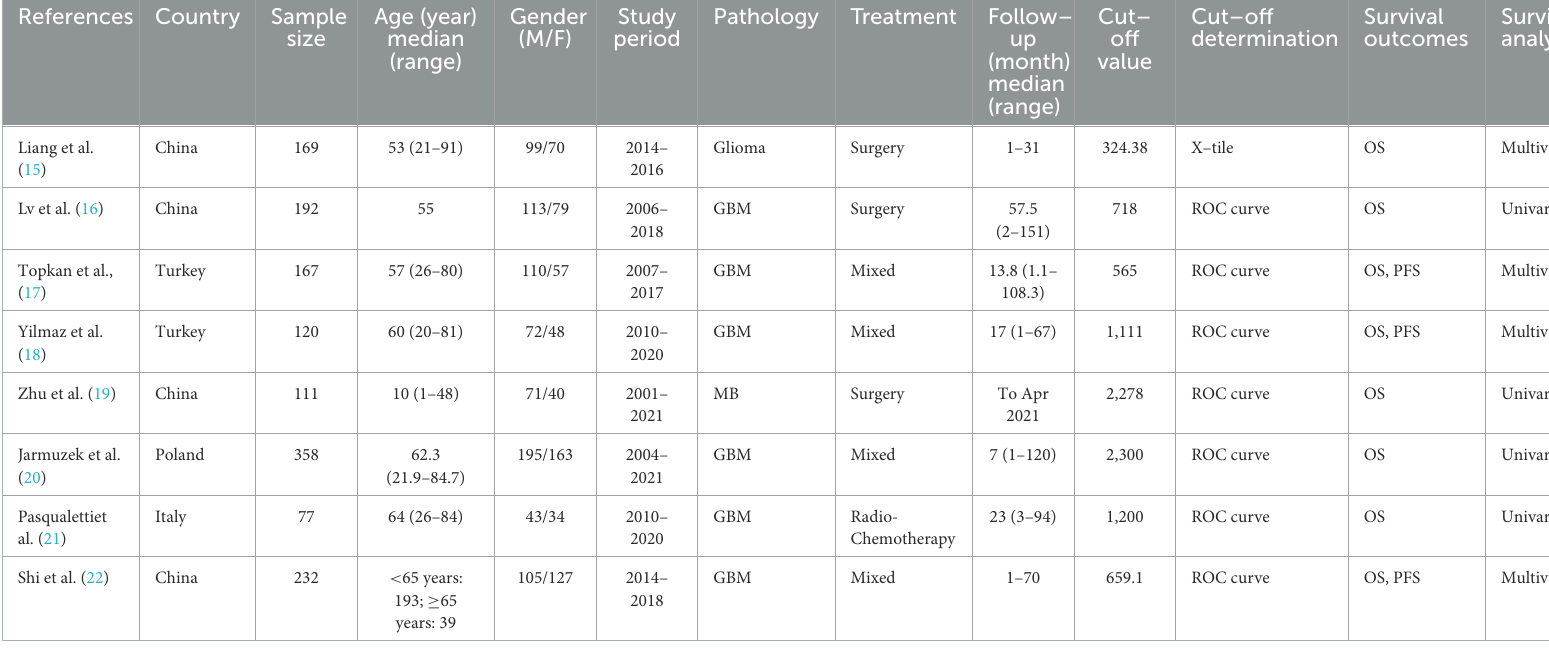
TABLE 1 Basic characteristics of included studies in this